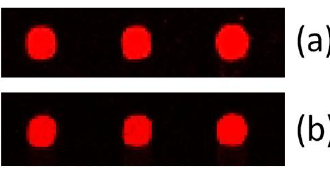
Figure 5. Processed chip showing spots obtained for the external ( a ) and internal ( b ) calibration at a concentration of 8.1 ng/mL